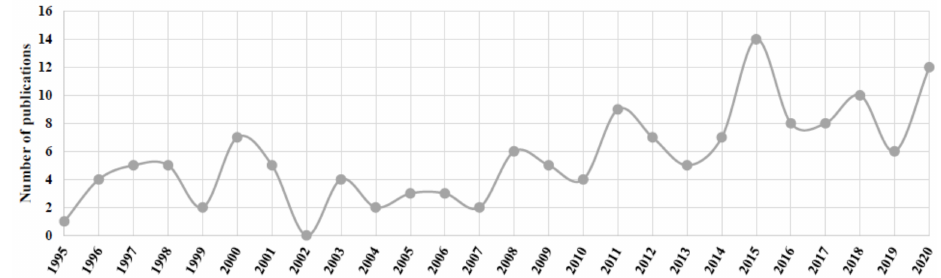
Figure 2. Number of publications as a function of the year (January 1995–December 2020) including all the articles from the database created after the application of inclusion and exclusion criteria.